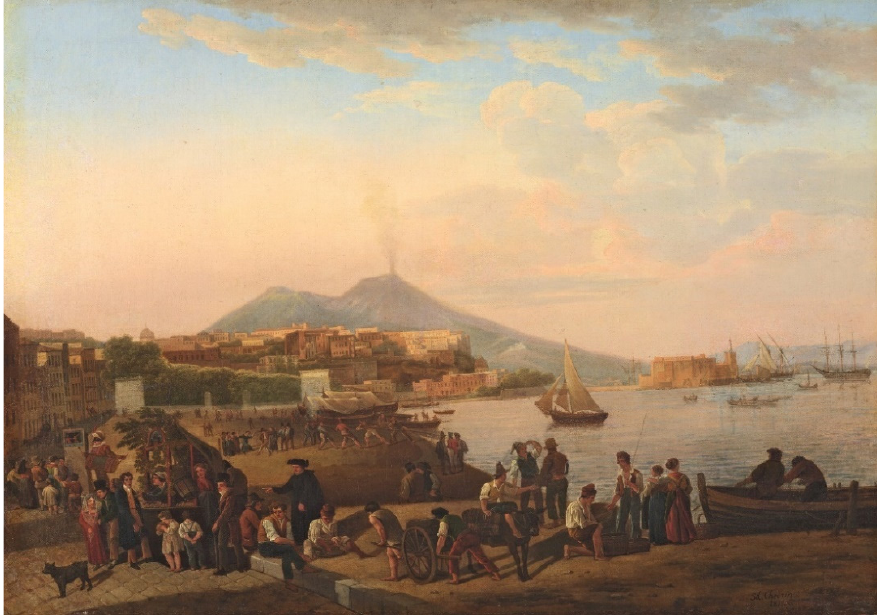
Figure 24. Sylvester Shchedrin. A View of Naples. On the Embankment (Riviera di Chiaia) , 1819. State Tretyakov Gallery, Moscow.